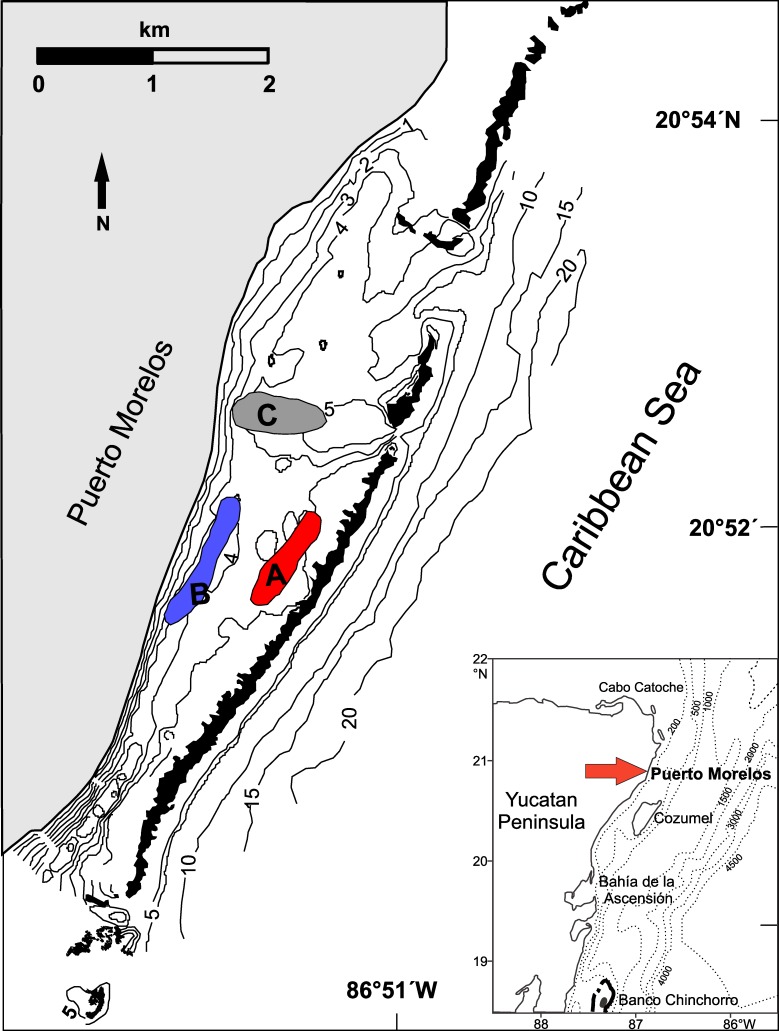
Study area.Location of the three sampling zones, zone A (red area), zone B (blue area), zone C (gray area), in the Puerto Morelos reef lagoon, Mexico. The black areas denote the reef crest. Isobaths are in meters. Inset shows the location of Puerto Morelos on the Mexican Caribbean coast. (Source: Servicio Académico de Monitoreo Meteorológico y Oceanográfico, Instituto de Ciencias del Mar y Limnología, Universidad Nacional Autónoma de México).